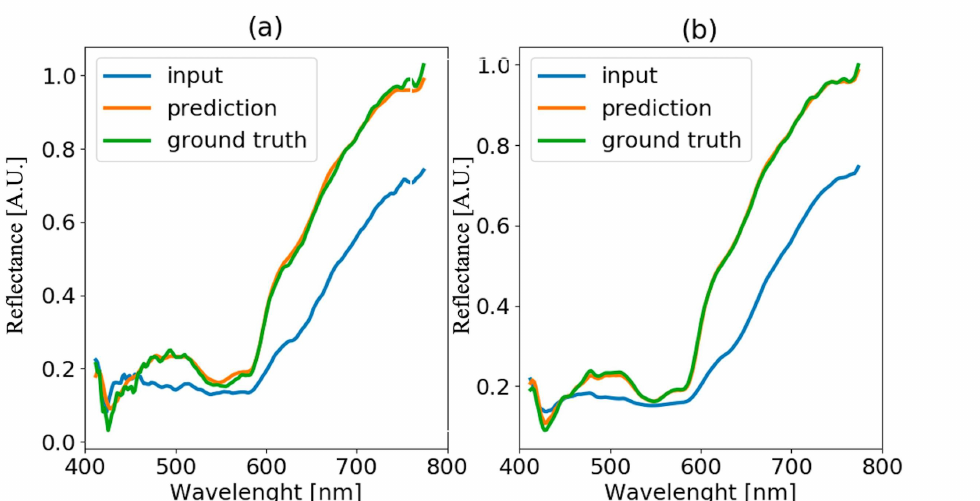
Figure 10. Blood spectra ( a ) and averaged blood spectra ( b ) comparison for the sample on wood substrate and acquired at time t = 50